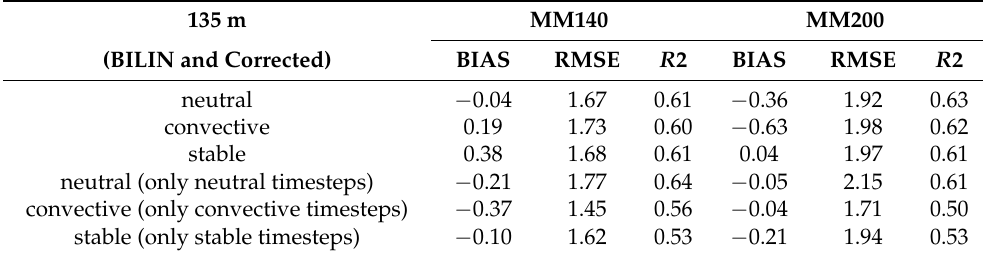
Table 3. Statistical analysis of multi-point downscaling methods with different stratifications at two metmast positions on site Rödeser Berg. The first three all use the whole timeseries, the latter three only those with the respective